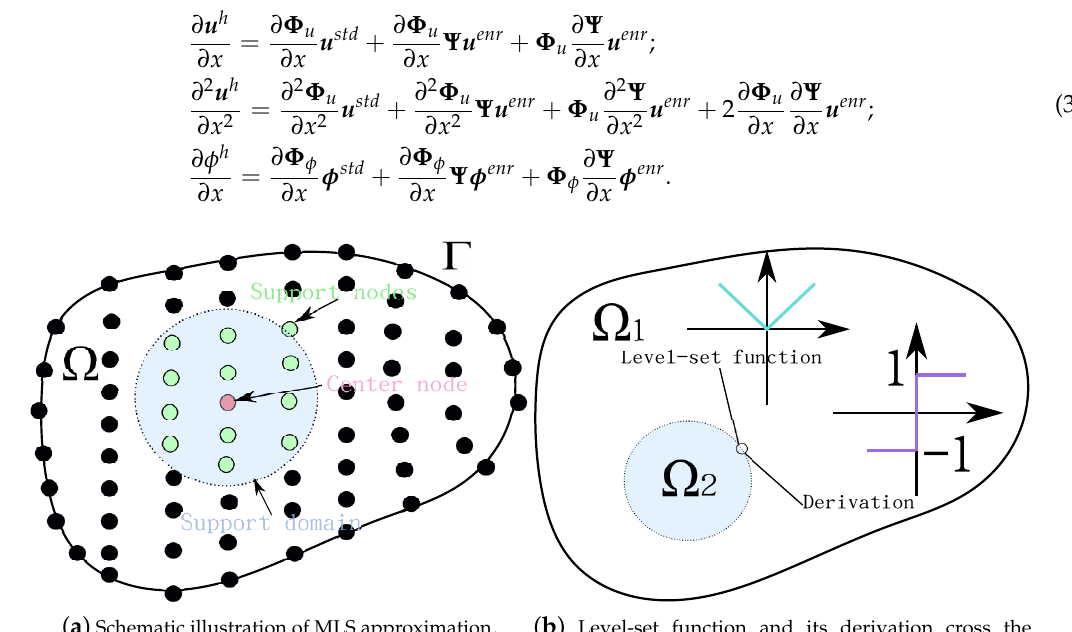
Figure 1. ( a ) Schematic illustration of Moving Least Squares (MLS) approximation and ( b ) the level-set function and its derivation across the